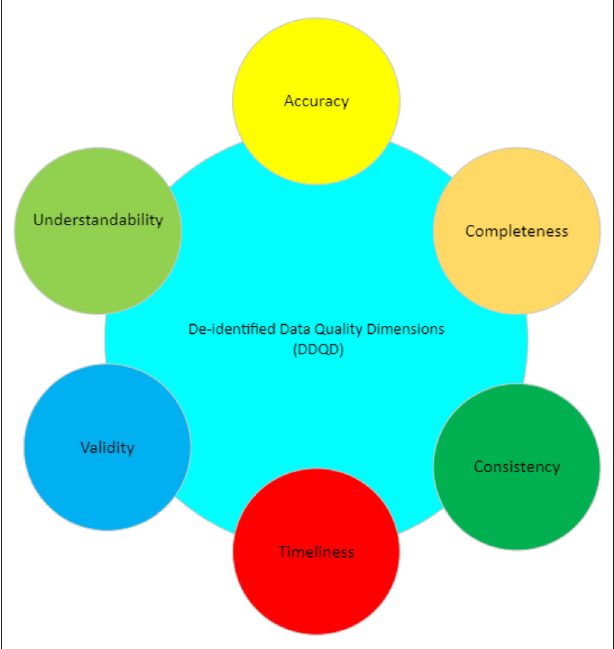
FIGURE 1 | De-identified data quality dimensions